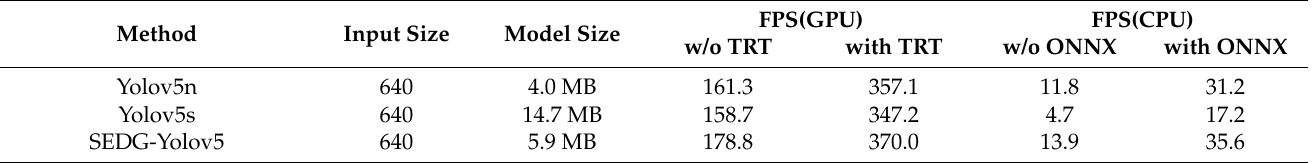
Table 6. Performance comparison with different detection models.